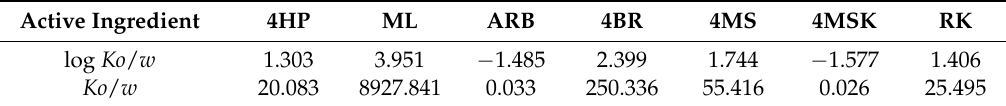
Table 1. Octanol-water partition coefficients (log Ko / w